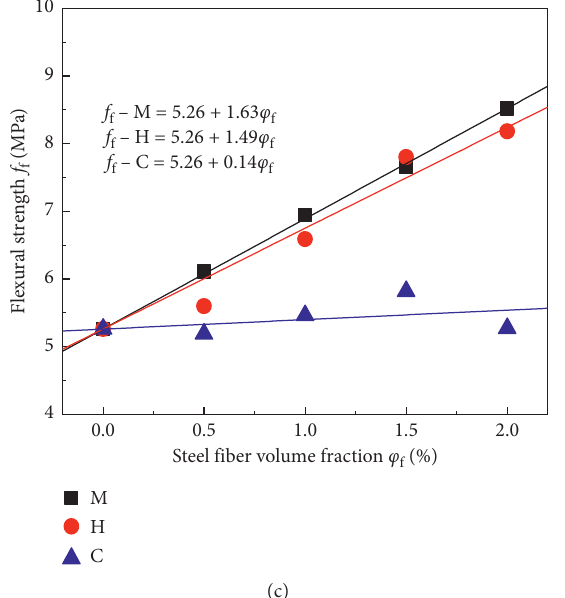
Figure 4: Relationship between strengths and steel fiber volume fraction. (a) Cube compressive strength. (b) Splitting tensile strength. (c) Flexural